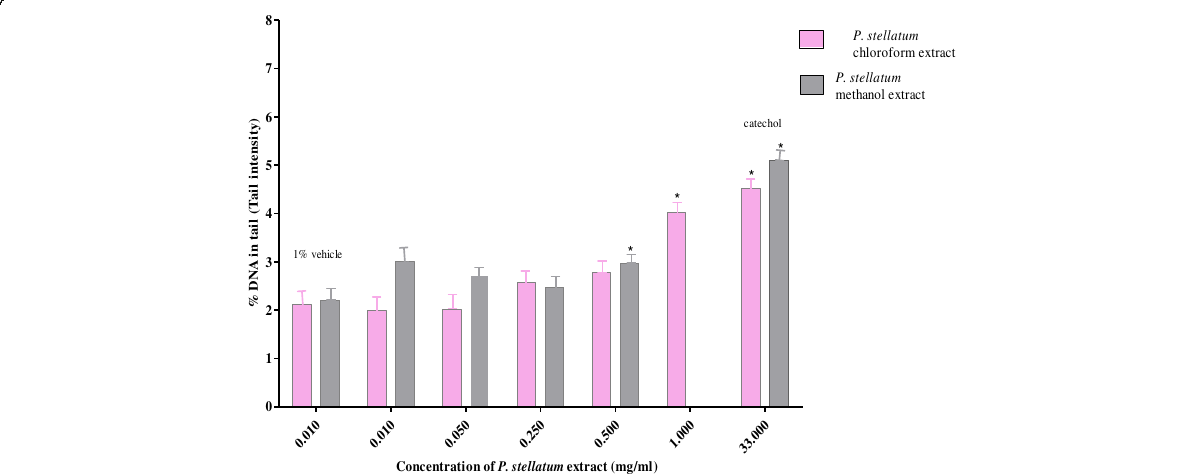
Fig. 2 Genotoxic effect of Ptrolobium stellatum extracts on HepG 2 cells: cells were exposed for 3 h and DNA damage was monitored as an increase in percentage of DNA in the tail (tail intensity) after 10 min of electrophoresis in the comet assay. % vehicle= 1% ethanol (negative control) and 3 mM catechol (positive control). The means of percentage of DNA in tail for at list three experiments were compared with the vehicle control using T-test for independent samples